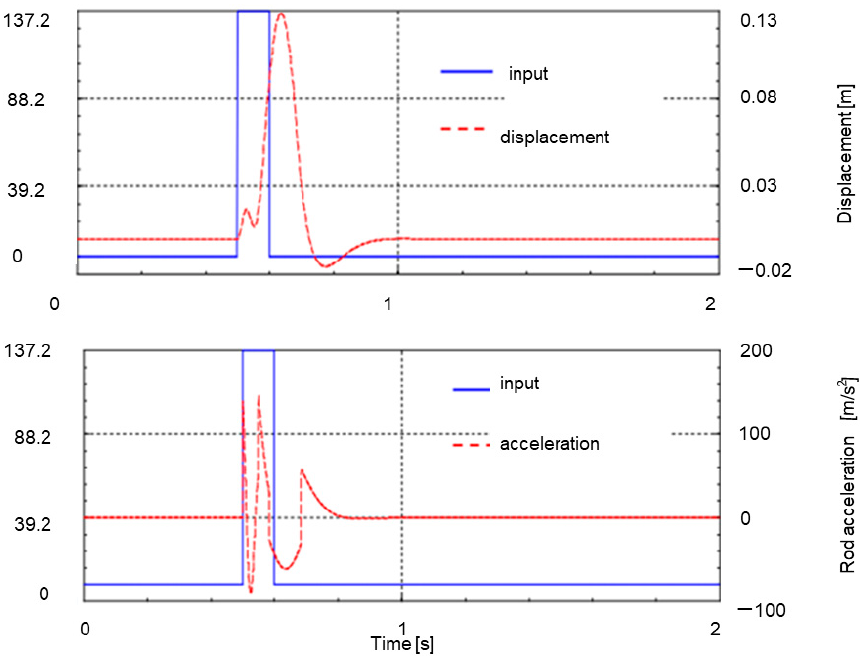
Figure 10. Time vs. rod displacement and acceleration by using spring and air compressibility (example 2).